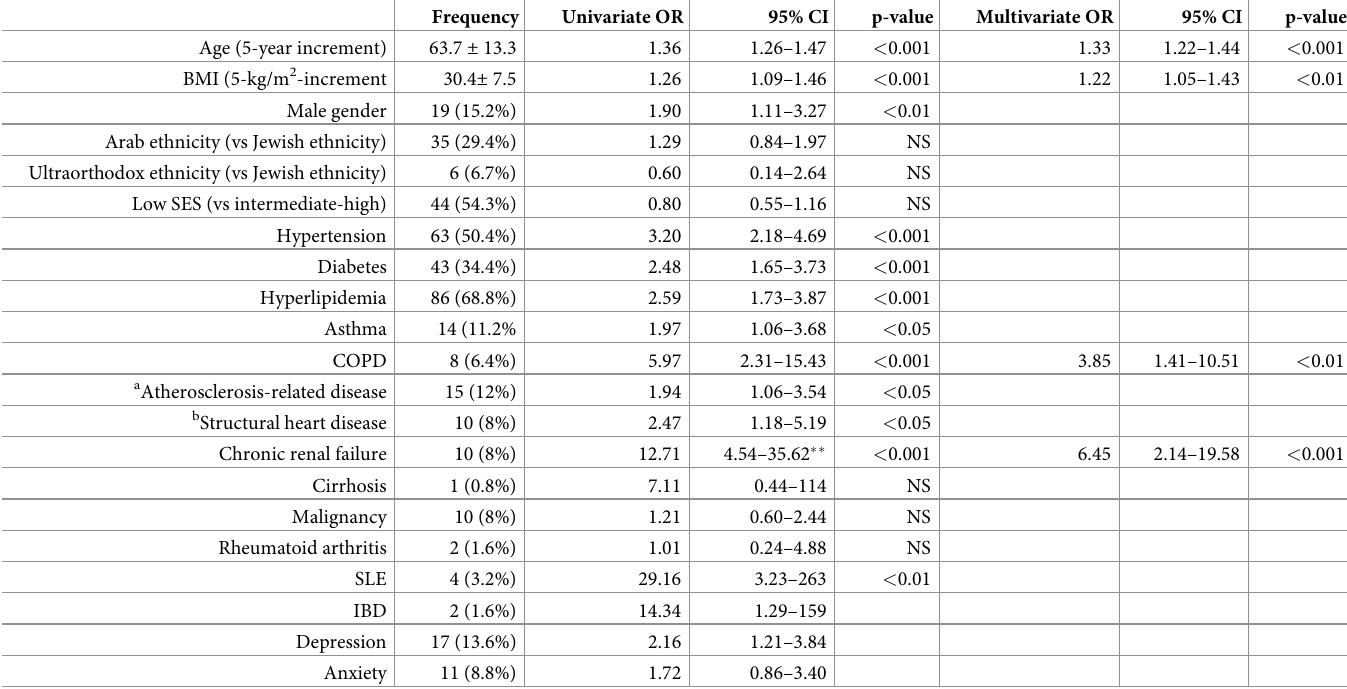
Table 3. Factors associated with COVID-19 hospitalization in controls, obtained from a univariate and a multivariate logistic-regression